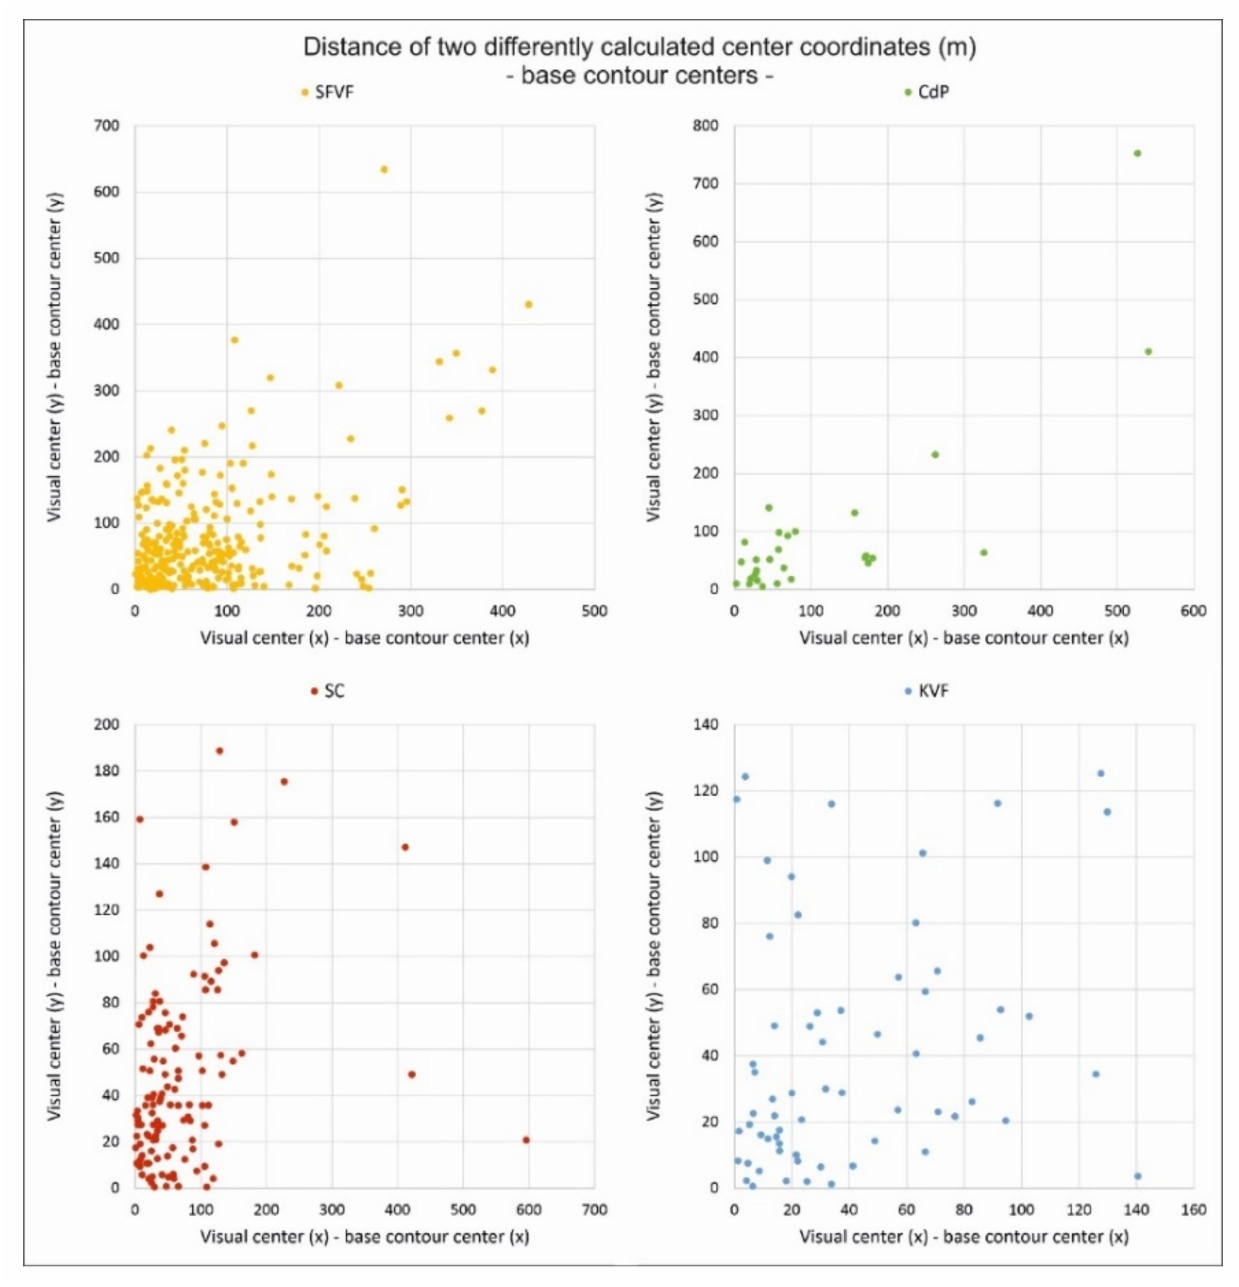
Figure 8. Distance of two differently calculated base contour centre